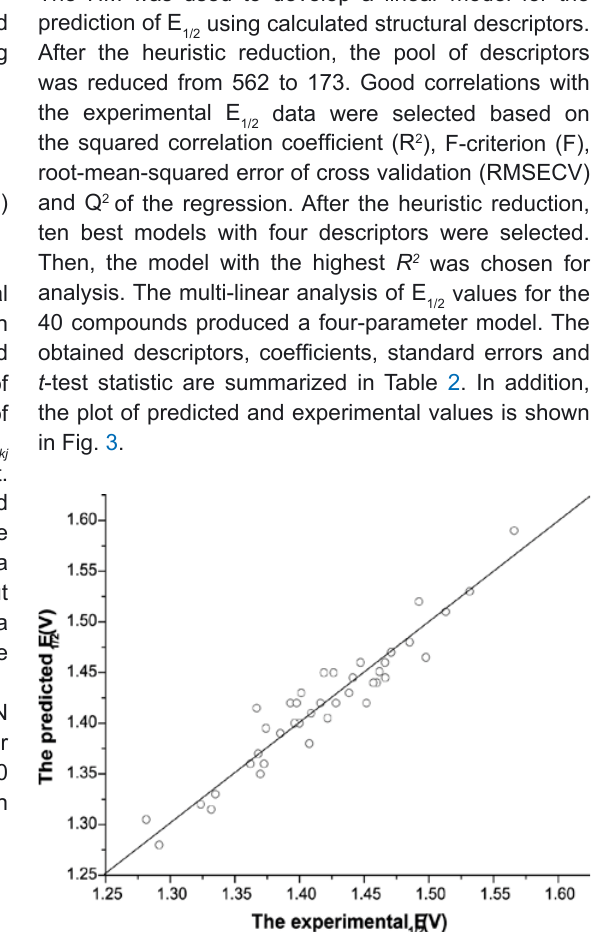
versus predicted E 1/2